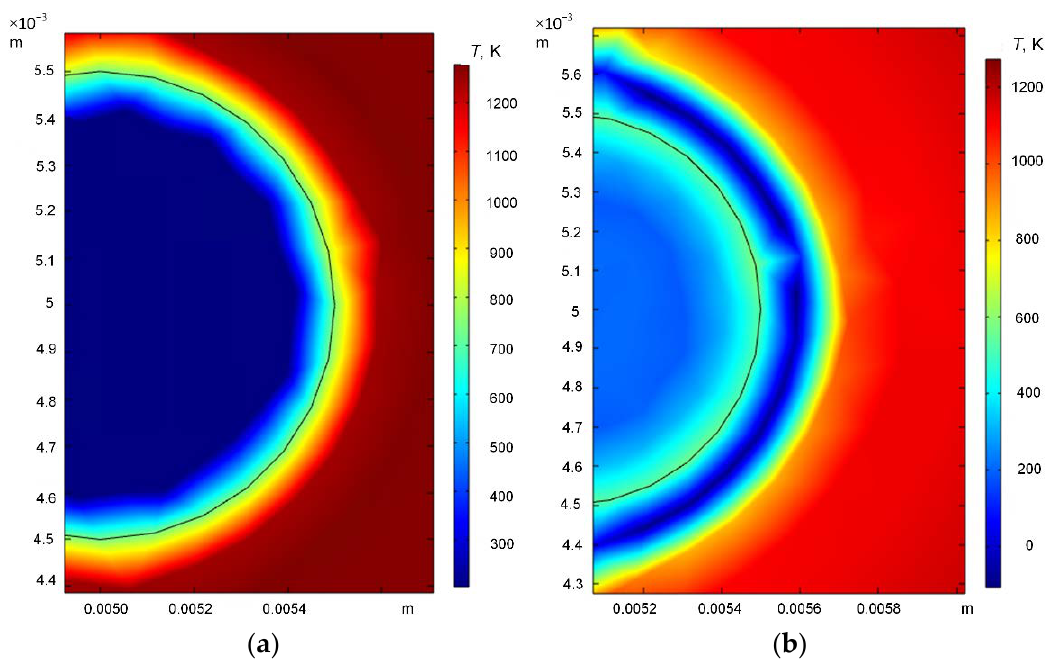
Figure 8. The temperature fields of the gas hydrate ignition area under the conditions of radiant heating when varying the mass rate of water evaporation from the gas hydrate sample’s surface at an air temperature of 1273 K and R g = 0.5 mm: ( a ) w evap = 0.01 kg/(m 2 ·s), ( b ) w evap = 0.1 kg/(m 2 ·s).